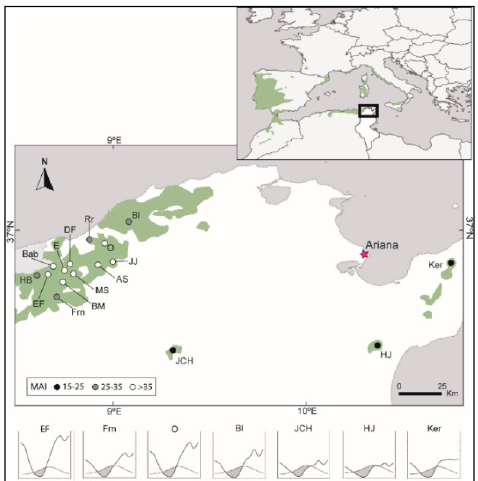
Figure 1. Overall distribution range of Quercus suber (green area) and geographical location in northern Tunisia of the 16 studied populations (circle) and the common garden experimental site (star). The color of the circle represents the De Martonne aridity index (MAI) value range. A climatic diagram of seven populations that include the three different MAI value ranges considered in this study have also been presented (grey areas indicate dry periods; left and right y-axes correspond to mean temperature and total precipitation, respectively). Population codes are as in Table 1.